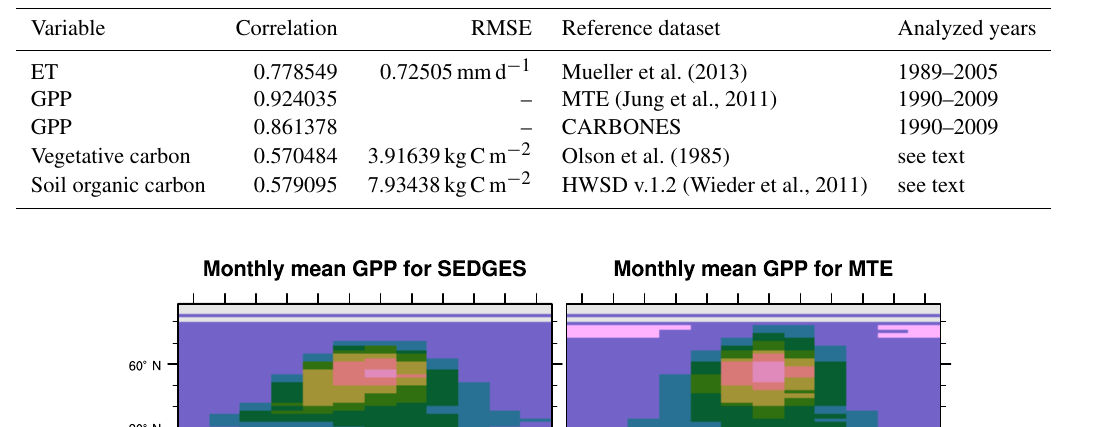
crease in SEDGES than in MTE. We suspect that the phase shift is due to the absence of both winter-deciduous leaf phenology and physiological constraints on the speed of ac- climation to temperature (discussed more in Appendix